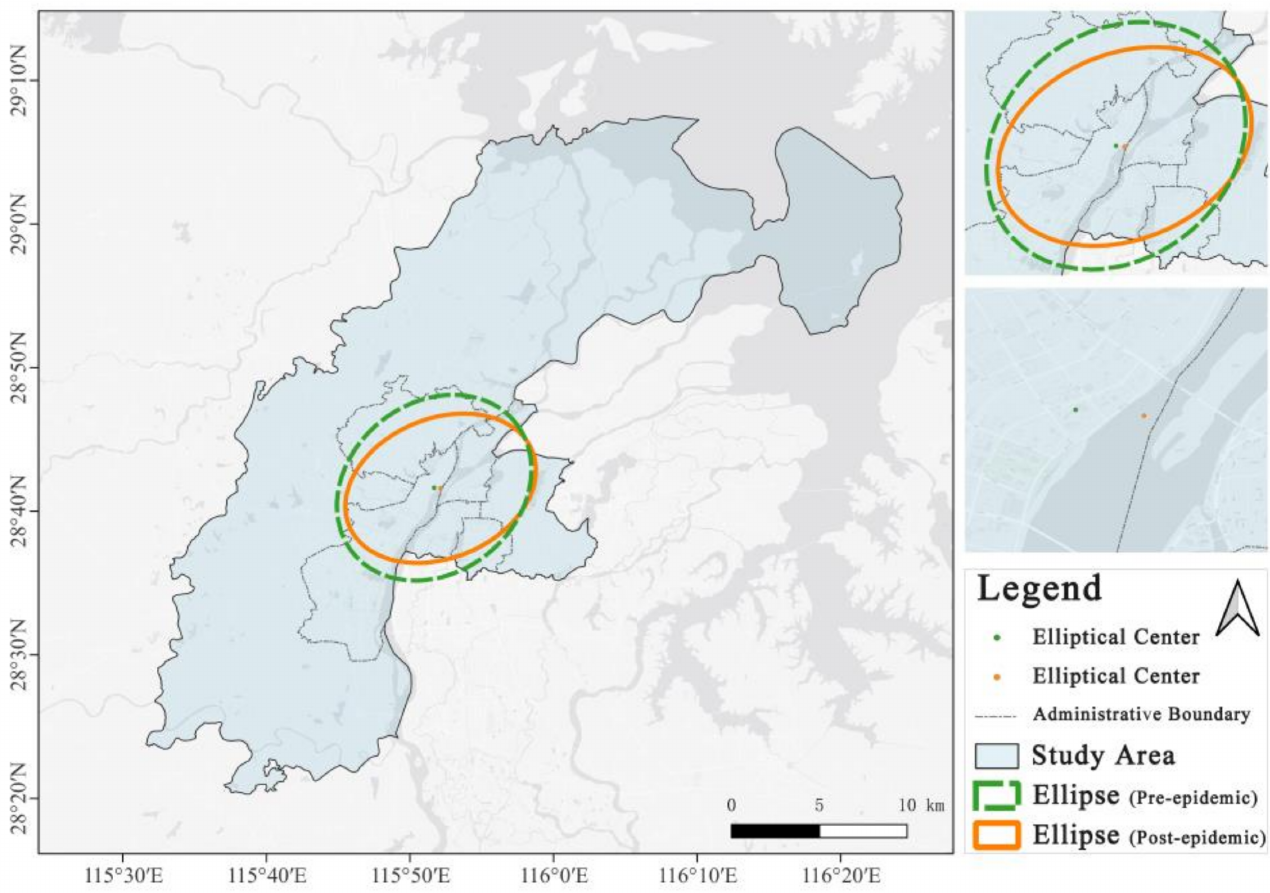
Figure 9. The standard deviation ellipse of outdoor sports venues.